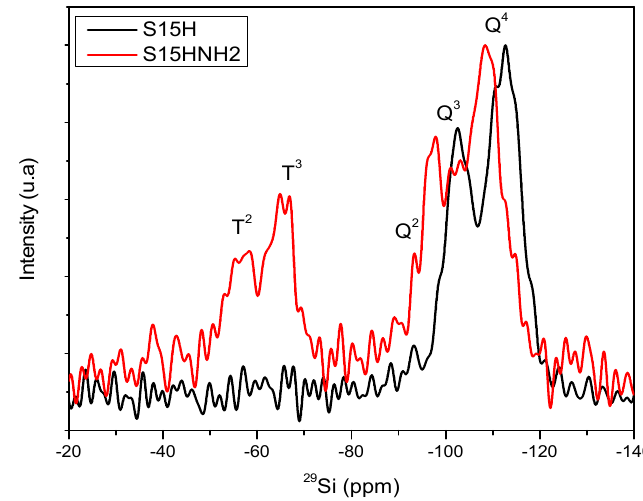
Figure 12. 29 Si NMR spectra (HPDEC) for the S15H precursor and APTES (S15HNH 2 ) modified samples.